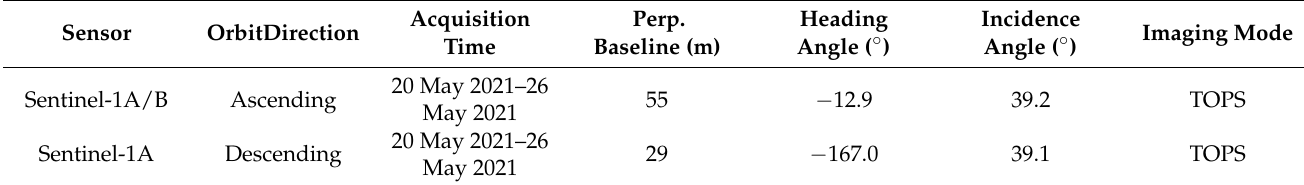
Table 1. The main parameters of the Sentinel-1 TOPS data used in this